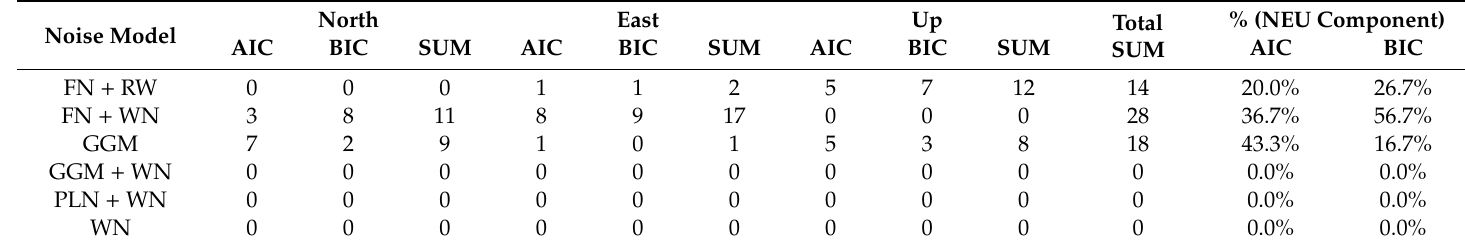
Table 3. Number of times that each noise model had the lowest Akaike or Bayesian information criterion (AIC or BIC) values for the North, East, and Up component based on the GOA time-series solution GOA_2.